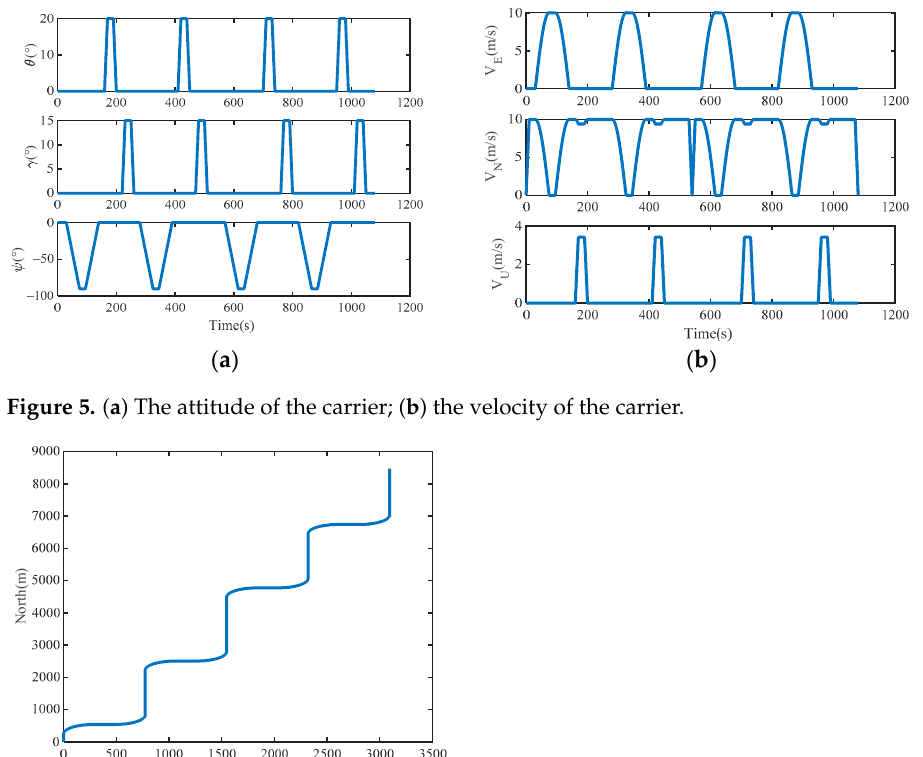
360″ Table 2. Initial alignment errors. Errors